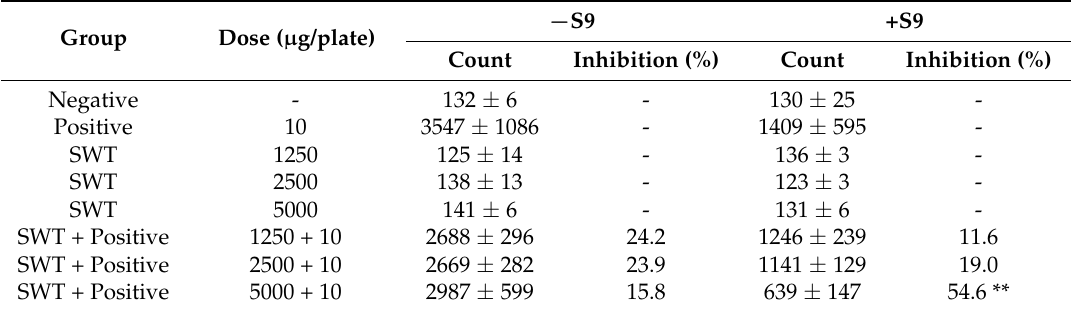
Table 1. Mutagenic activities and antimutagenic activities of SWT with or without